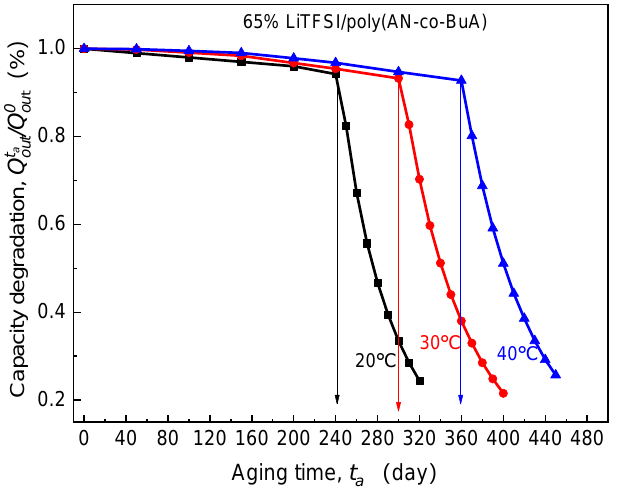
Figure 9. Effect of operating temperature on electrolyte-aging induced capacity degradation.